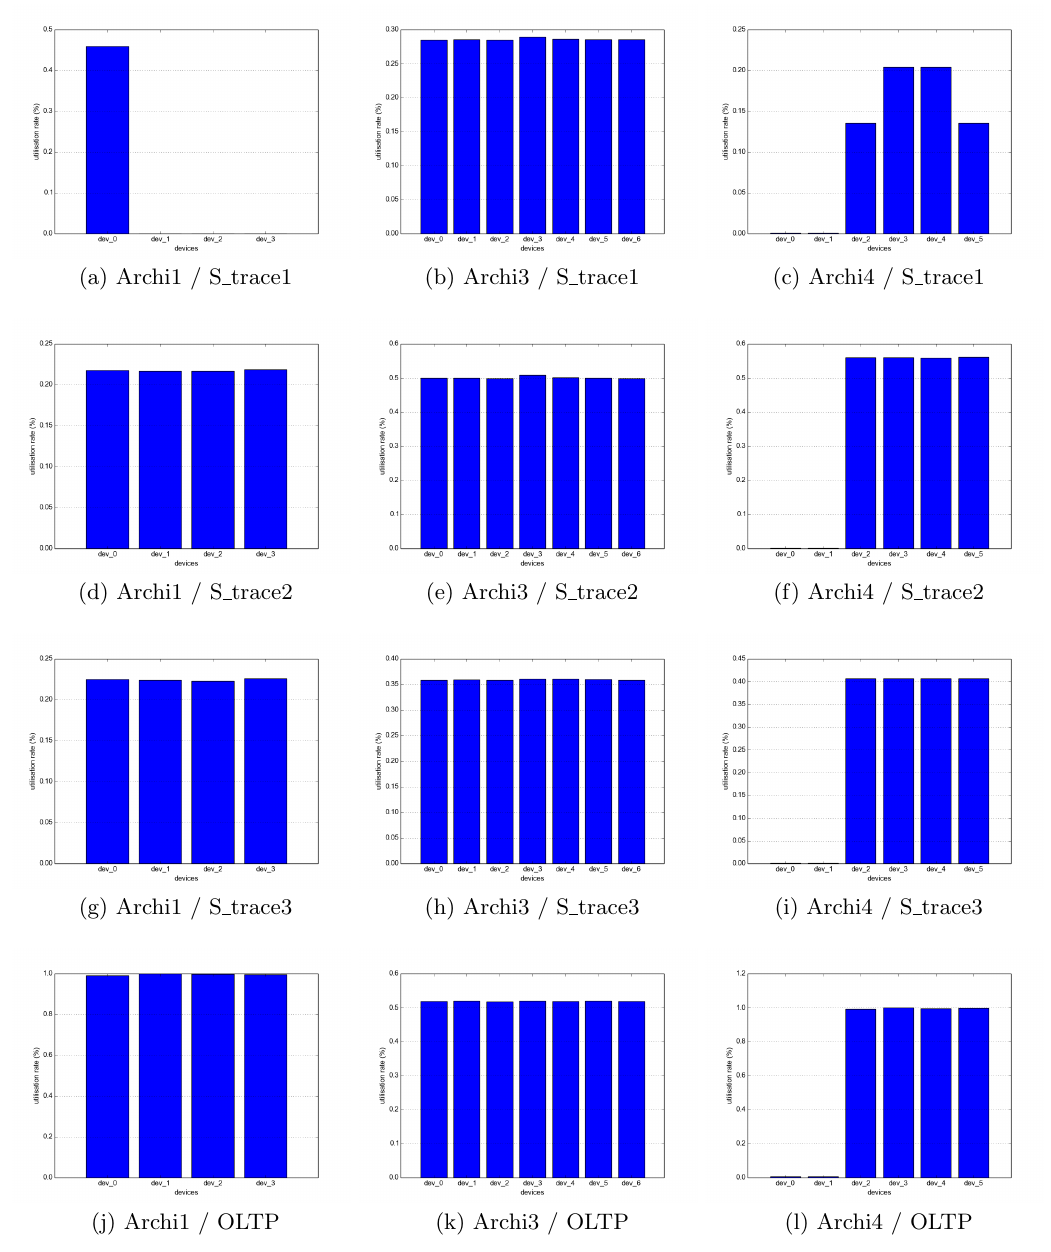
Figure 7: Device utilisation